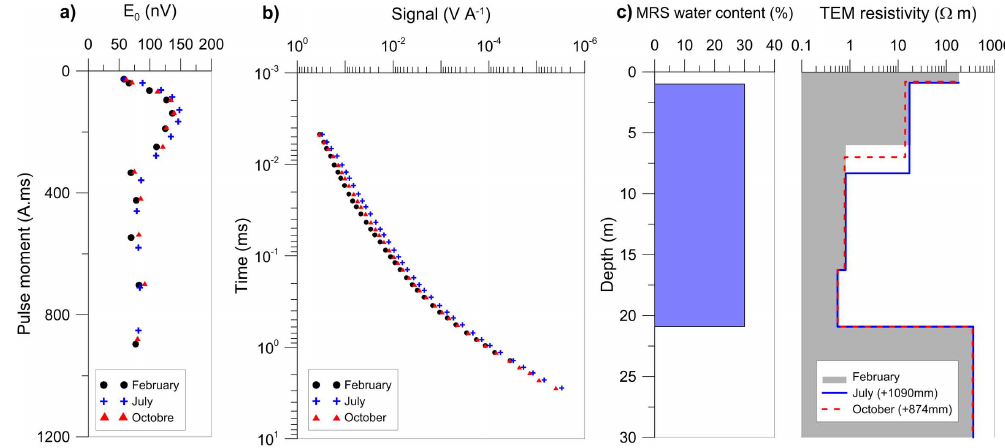
Fig. 9. TEM73 and MRS 1 time lapse. (a) MRS signals, (b) TEM signals and (c) geophysical